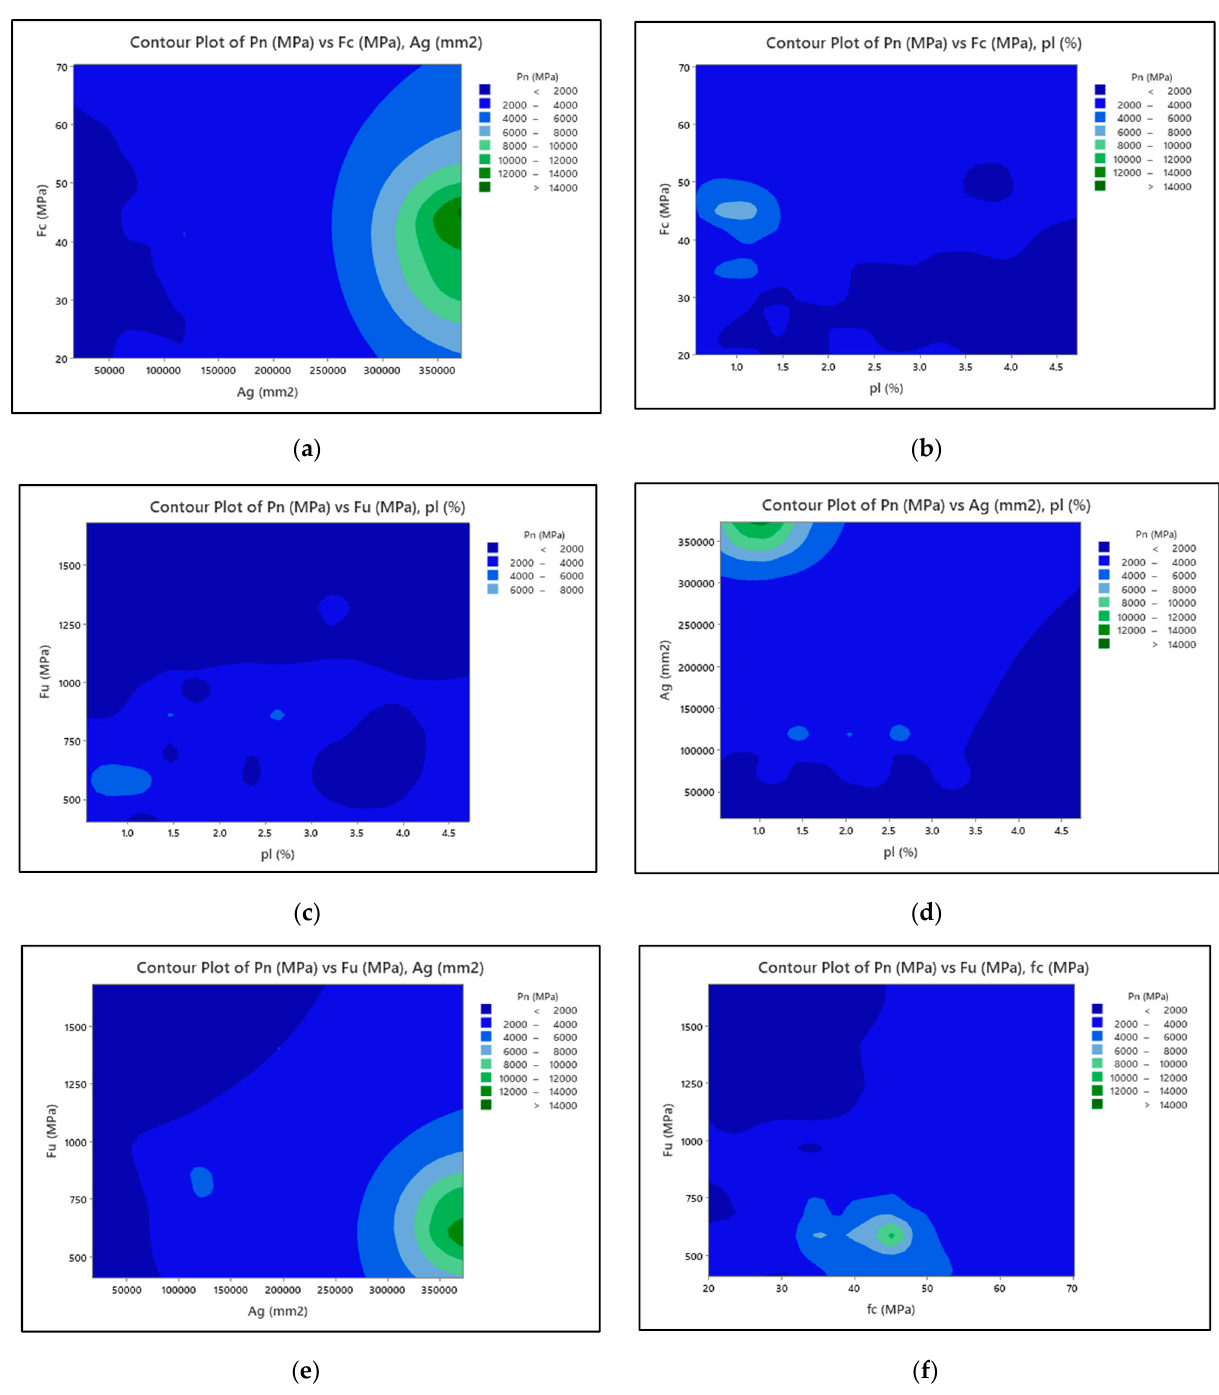
Figure 8. Parametric analysis of the axial capacity of GFRP - made RC column .